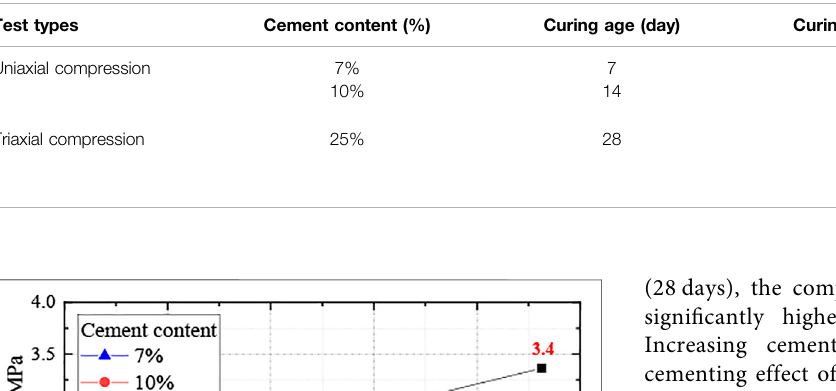
TABLE 1 | Test conditions for the strength characteristics of the CPB.